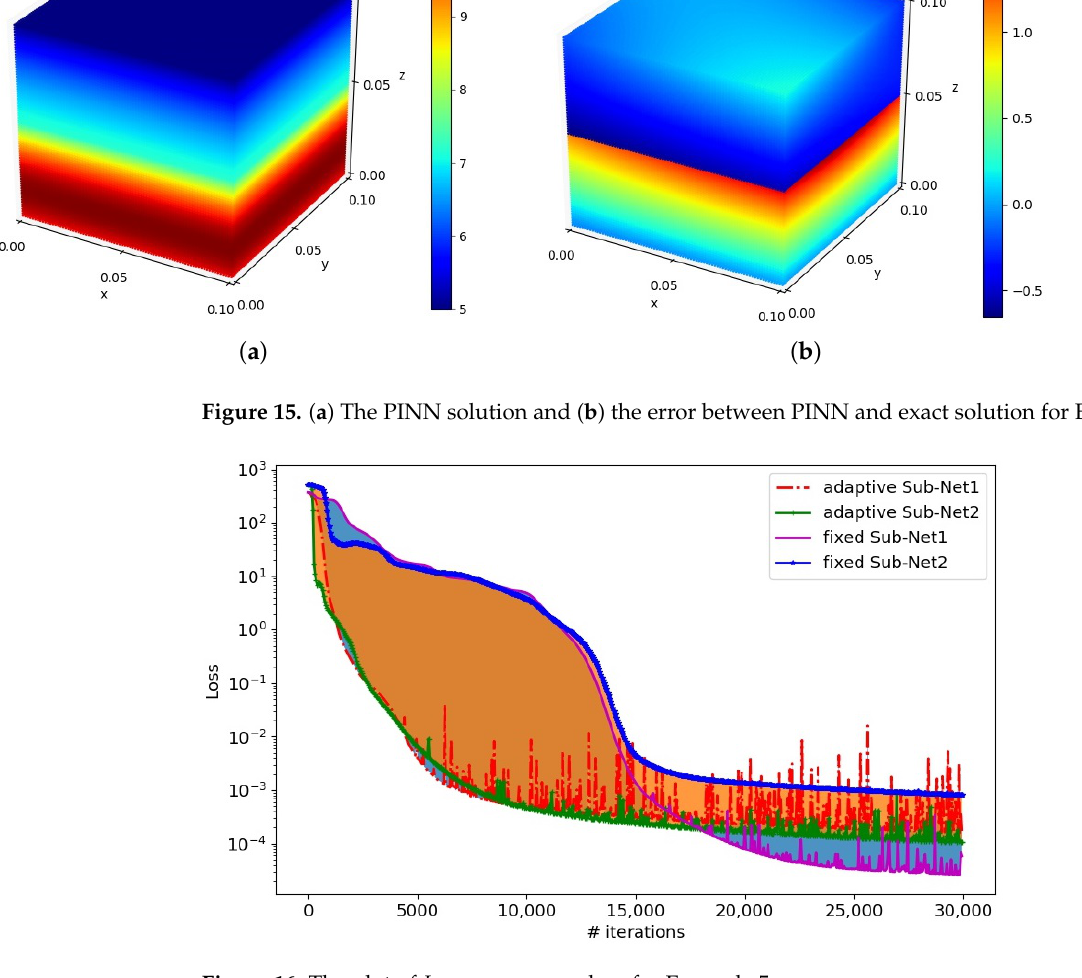
Figure 16. The plot of L s average error loss for Example